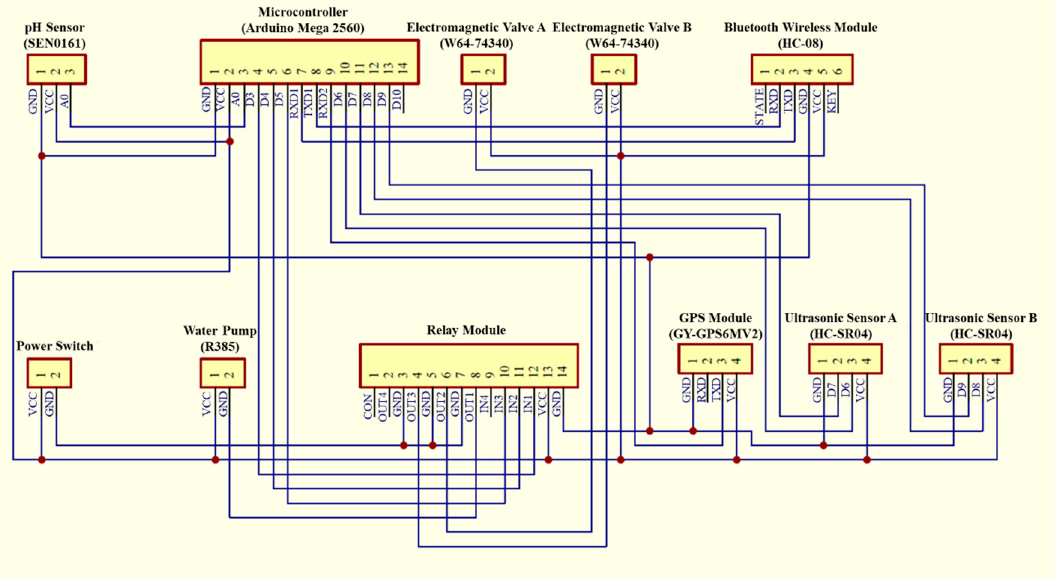
Figure 9. Circuit diagram of the water quality monitoring system.